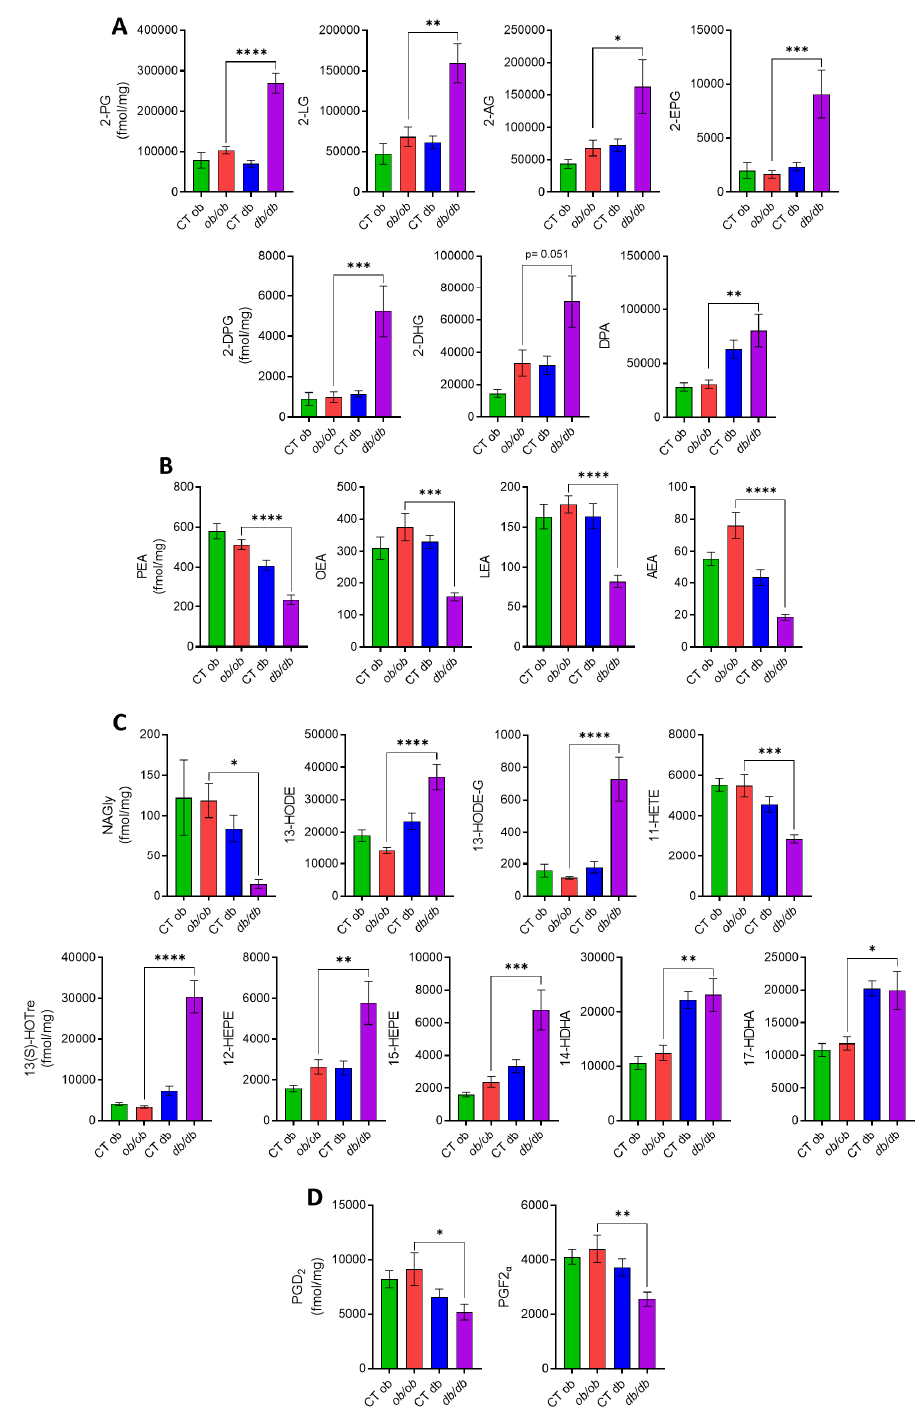
Figure 2. Different eCBome tone in the duodenum of ob/ob and db/db mice. ( A – D ) Concentrations of the eCBome-related mediators in the duodenum (fmol/mg wet tissue weight) measured by HPLC-MS/MS. Data are presented as the mean ± S.E.M of n = 7–10. * p ≤ 0.05, ** p ≤ 0.01, *** p ≤ 0.005, **** p ≤ 0.001.